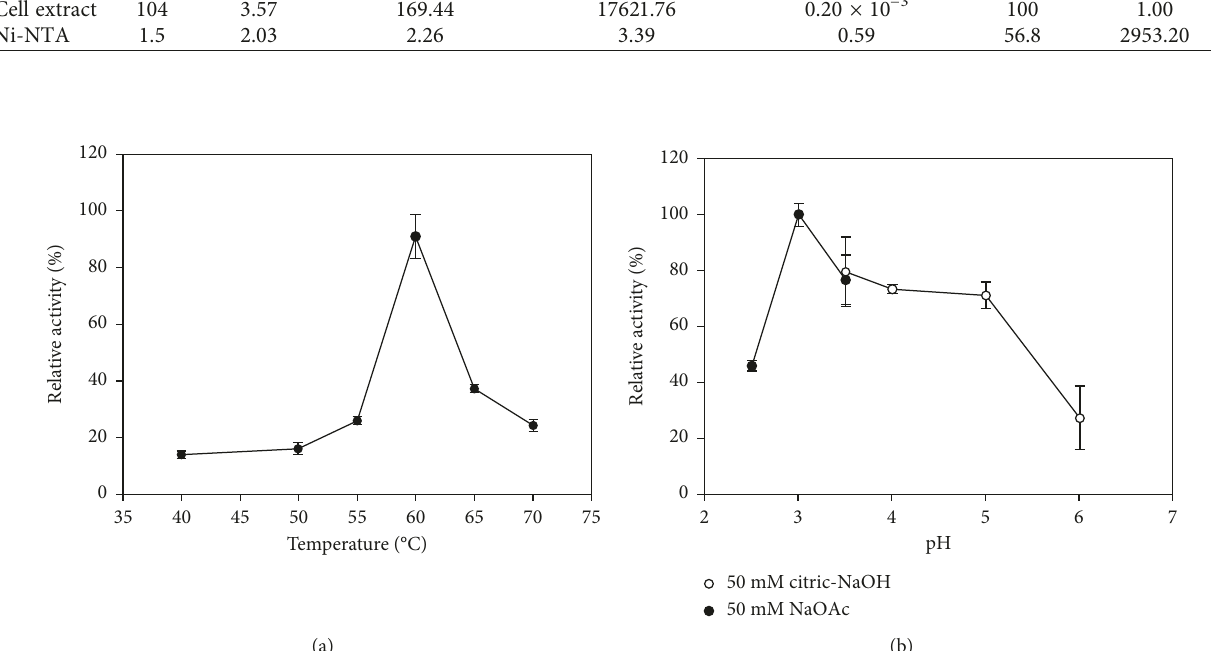
Figure 1: Effect of temperature and pH on Bacteroides thetaiotaomicron α -glucanotransferase (Bt α GTase) enzyme activity. (a) The optimal temperature and (b) pH were measured using 0.02% amylose and 0.05% maltose as substrates.